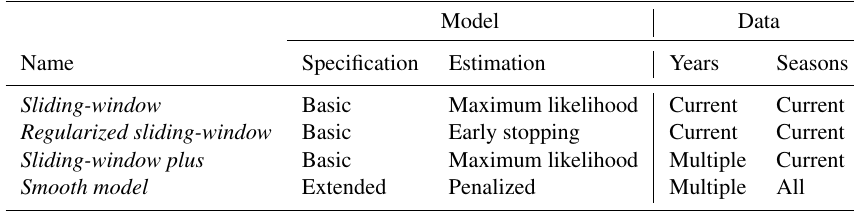
Table 1. Overview of time-adaptive training schemes, distinguished by model specification/estimation and training data selection correspond- ing to errors sources (vi) and (v), respectively. The basic model specification refers to Eqs. (3)–(4), in contrast to the extended Eqs. (6)–(7).